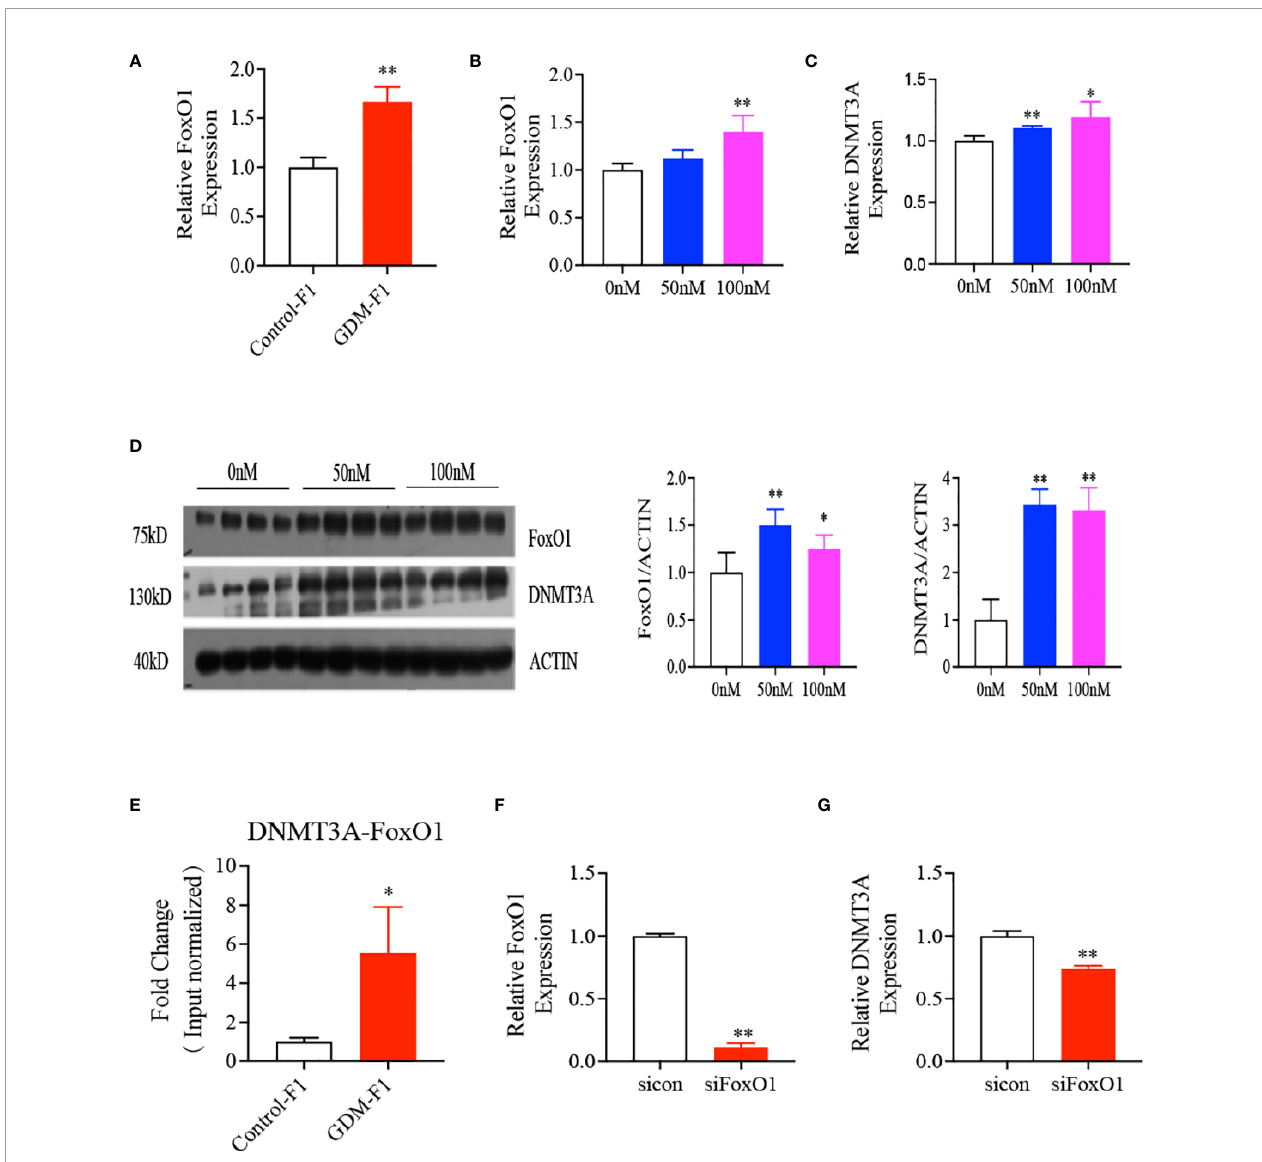
FIGURE 5 | Interaction between FoxO1 and DNMT3A. (A) Representative mRNA levels of FoxO1 in the liver of 8-week-old mice (every group contains 10 mice); (B – D) FoxO1, DNMT3A gene expression in HepG2 cells treated with 0, 50, 100 nmol/L insulin concentration after 24 hours by RT-qPCR or Western Blot (n = 4 replicates/group in at least three independent isolations); (E) chip-qPCR analysis to detect binding between FoxO1 and DNMT3A. IgG was as negative control. (F, G) mRNA level of FoxO1 and DNMT3A after silence interfere FoxO1 on HepG2 cells (n = 4 replicates/group in at least three independent isolations); For RT- qPCR, Data were analyzed with the Eq. 2- DD CT, where DD CT = D CT (treatment group) - D CT (control group), and D CT = D CT (sample) - D CT (internal control). The values were normalized to ACTIN mRNA levels, ACTIN was an internal control. In all panels, data are presented as mean ± SD, * P < 0.05, ** P < 0.01. Signi fi cance was determined by Student t